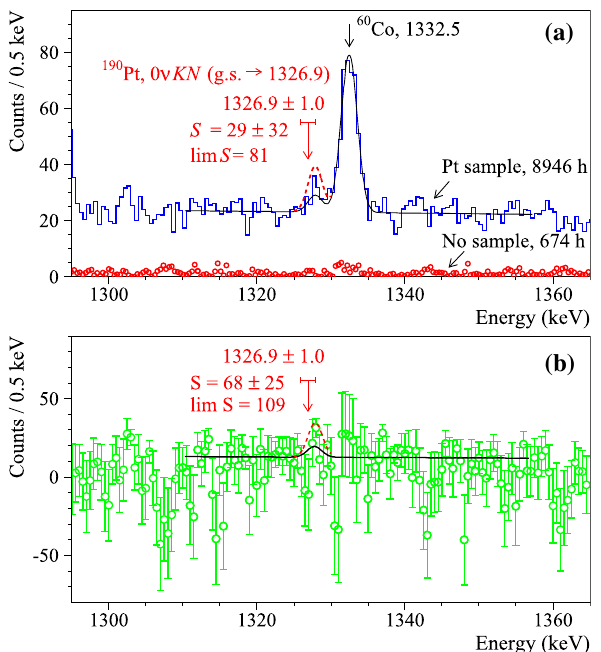
Fig. 8 TheenergyspectragatheredwiththePtsample(withnosample) by the detector system where the γ peak from possible resonant 0 ν K N transition to the 1,2 1326.9 keV level of 190 Os is expected ( a ). The background-subtracted spectrum is shown in panel ( b ). The fits of the data are shown by solid lines (see text for details of the background models), while the excluded peaks are presented by dashed lines